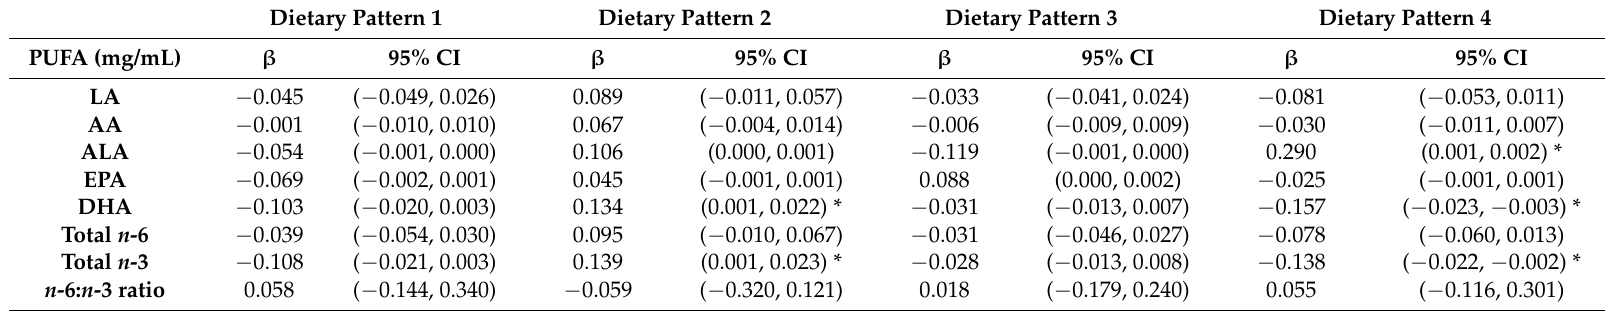
Table 4. Multiple regression analysis of dietary patterns as predictors of total serum PUFA status (mg/mL) ( n = 268) total g/day.